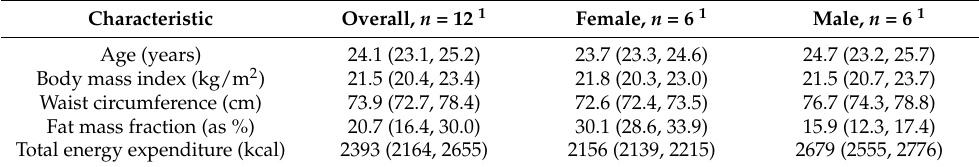
Table 1. Subjects’